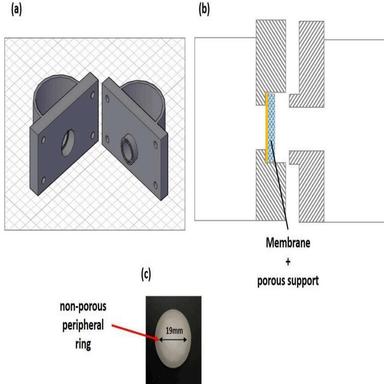
a) Drawing of the cell, b) side view showing the assembly of the two half-cell with membrane and porous support and c) glass frit used as the porous support.